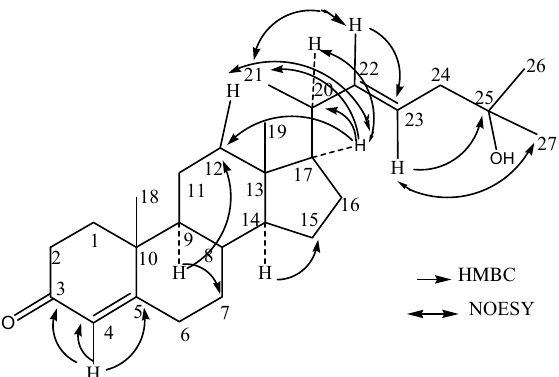
Figure 2. The key HMBC and NOESY correlations of compound 1 .